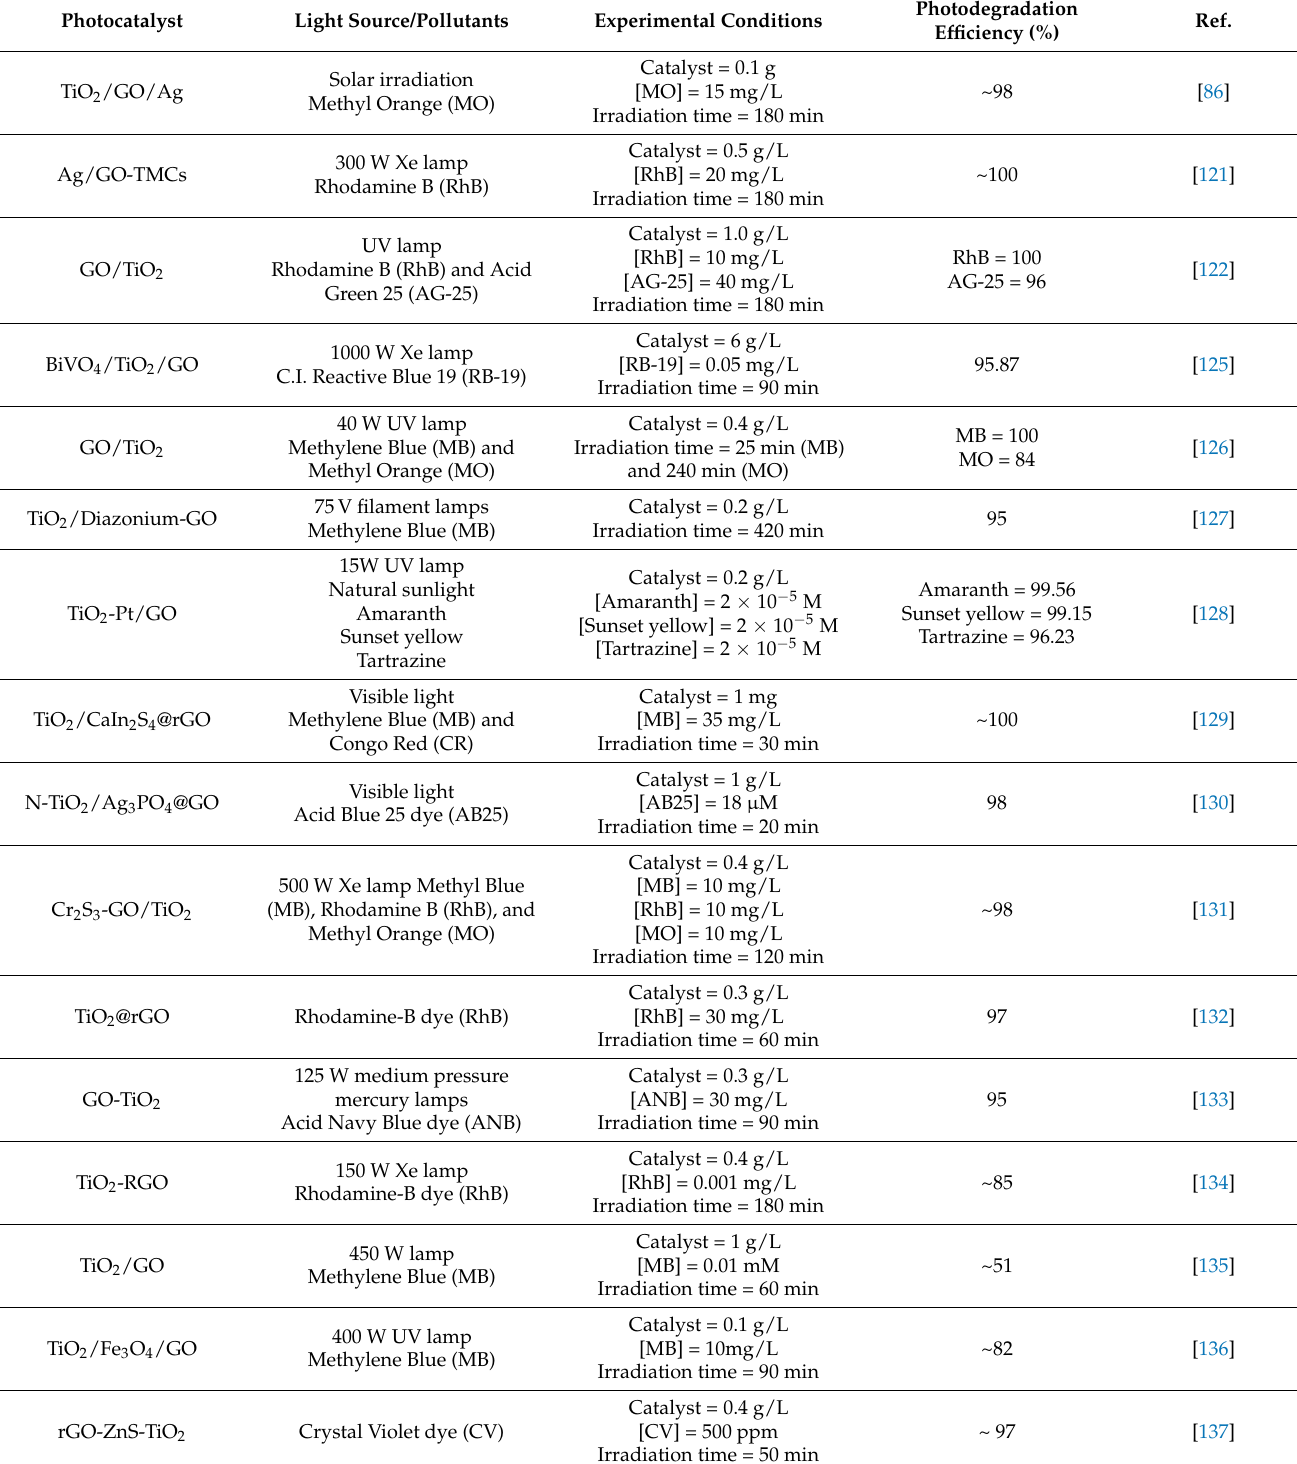
Table 5. GO/TiO 2 -based photocatalyst for photodegradation of dye.